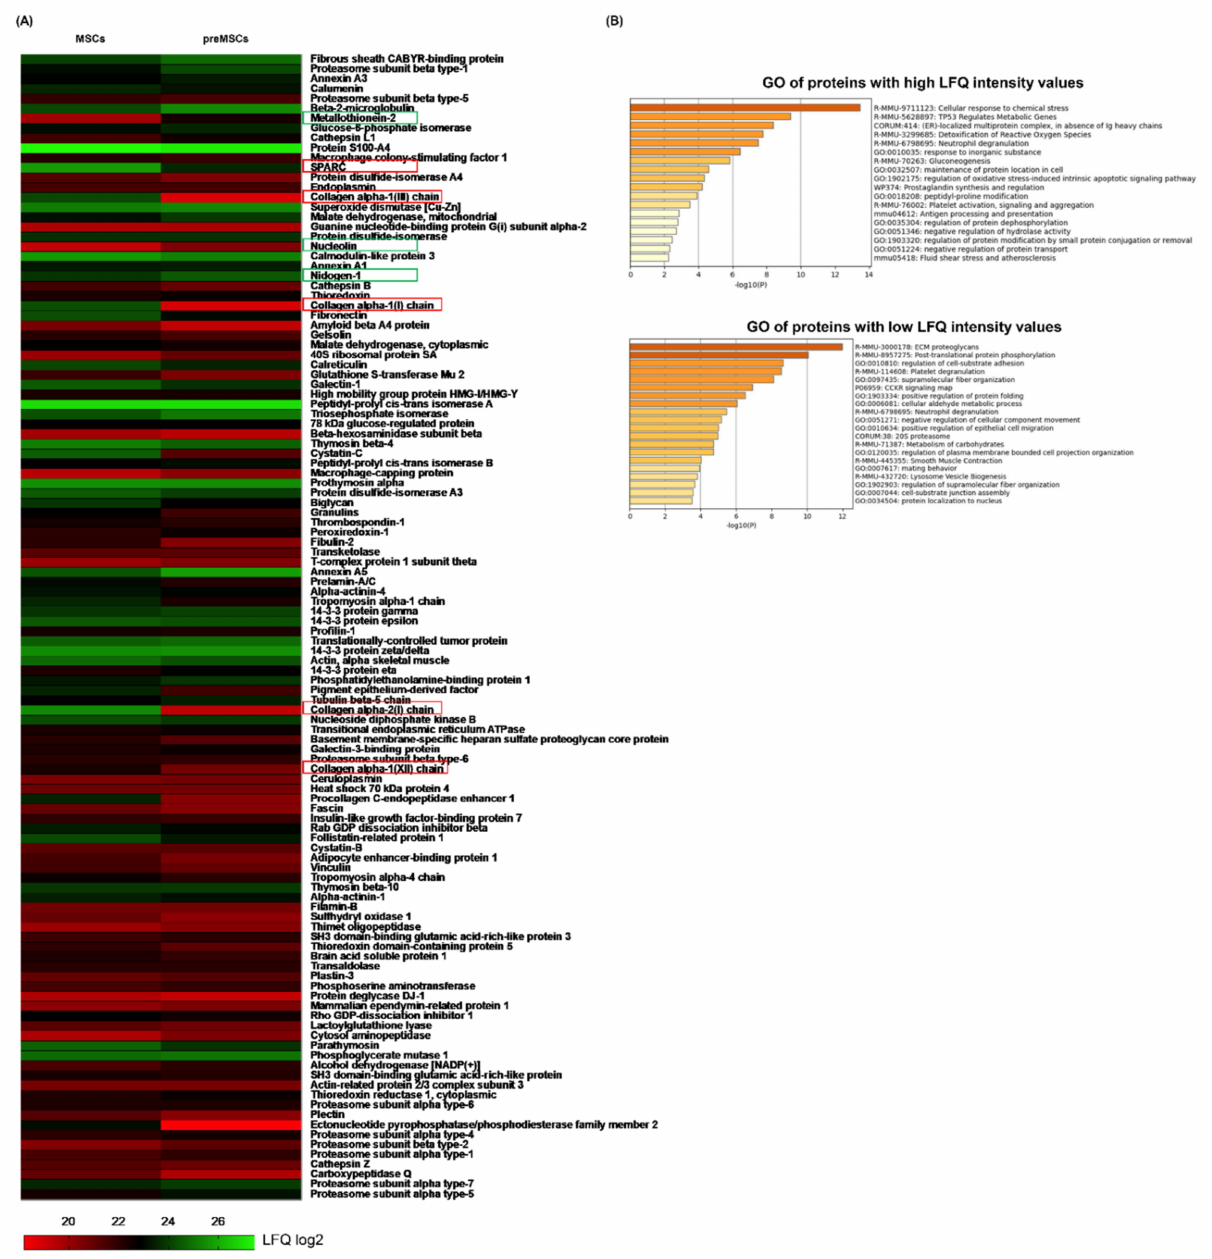
Figure 4. Characterization of secretome from MSCs and preMSCs. ( A ) Heat map of 116 peptides which were detected in the supernatants of MSCs and preMSCs on the basis of log2-transformed LFQ intensity values. ( B ) Gene ontology (GO) enrichment analysis of proteins found to be more or less enriched in the supernatants of